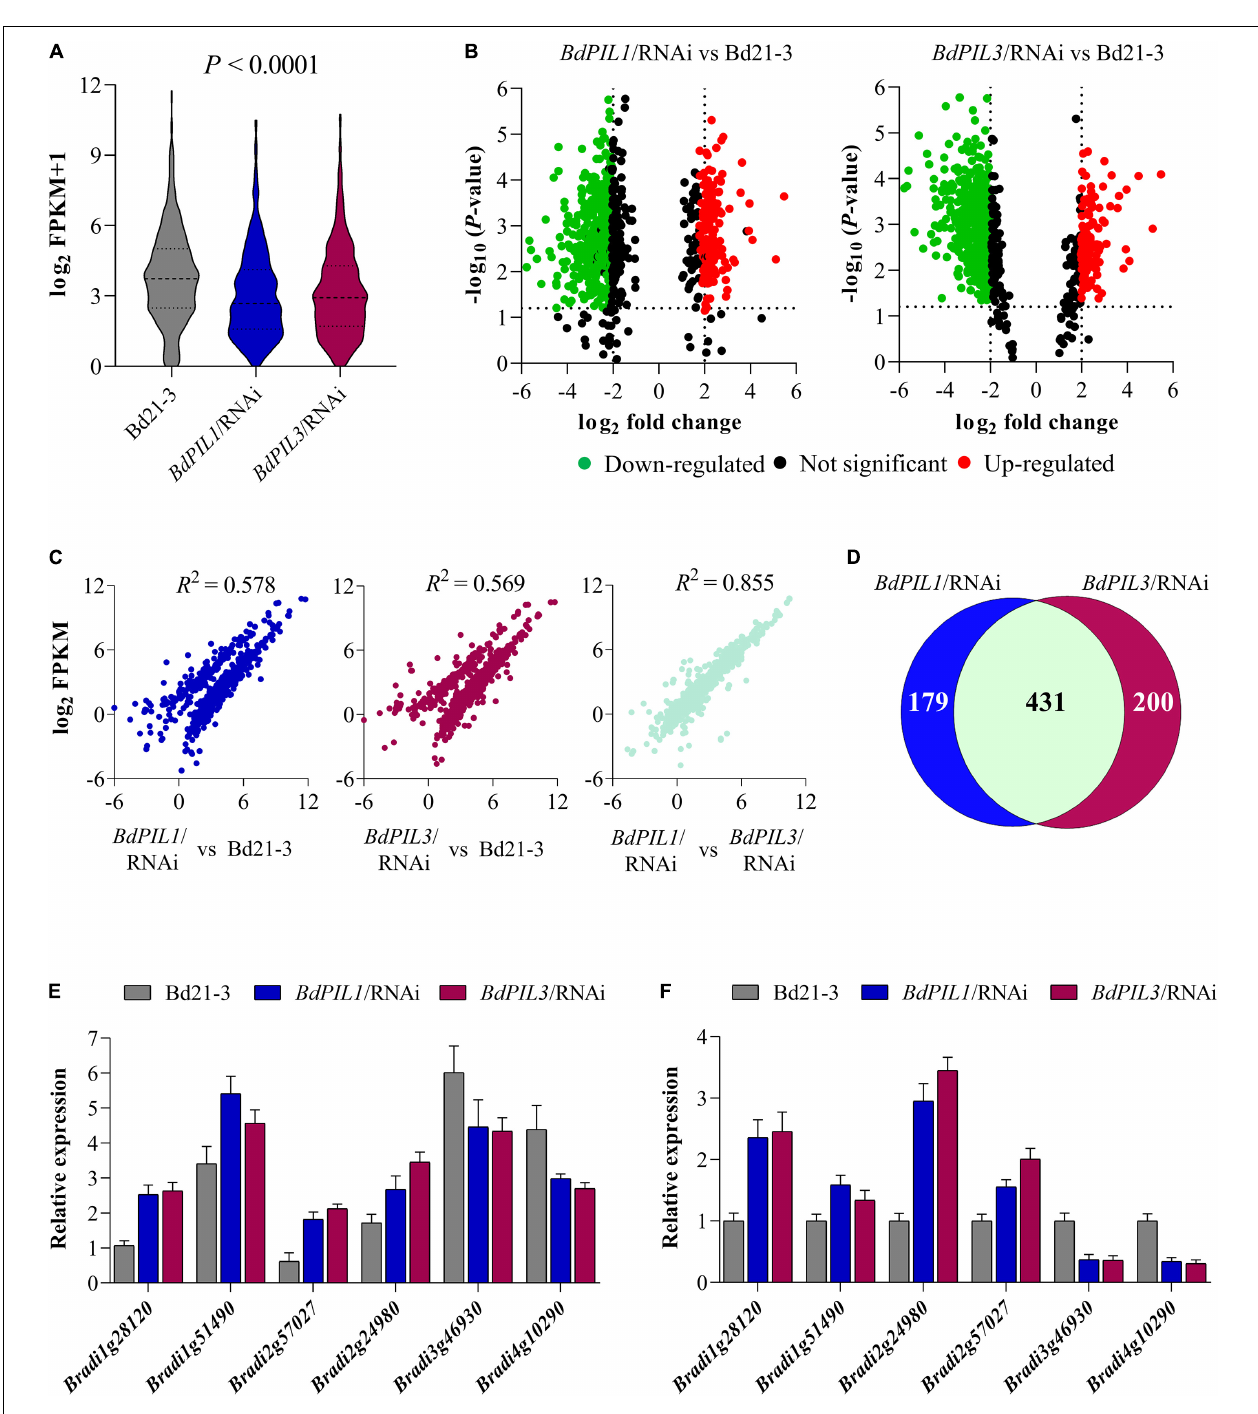
FIGURE 5 | RNA-seq analysis of the RNAi plants versus Bd21-3 (wild-type) plants. (A) The range and distribution of FPKM values. (B) Volcano-plots of differentially expressed genes (DEGs) in BdPIL1 /RNAi (left) and BdPIL3/ RNAi (right) versus Bd21-3. Significantly downregulated and upregulated genes are shown in green and red dots, respectively. The vertical lines highlight log fold changes of ± 2, whereas the horizontal lines represent the values of significant differences in gene expression at P < 0.05. (C) Correlation analysis of the FPKM values. The scatter plots show the pairwise correlation among the libraries of three samples using Pearson’s correlation, and R 2 values represent the correlation coefficients at P < 0.001. (D) Venn diagram to show the number of DEGs in BdPIL1 /RNAi and BdPIL3 /RNAi versus Bd21-3. The number of genes regulated by both BdPIL1 and BdPIL3 are indicated by the overlap between the two circles. (E,F) Transcriptome data of selected DEGs obtained from RNA-seq analysis (E) and analyzed using qRT-PCR (F) for data validation. Data represent the means ± SD of three independent biological replicates.